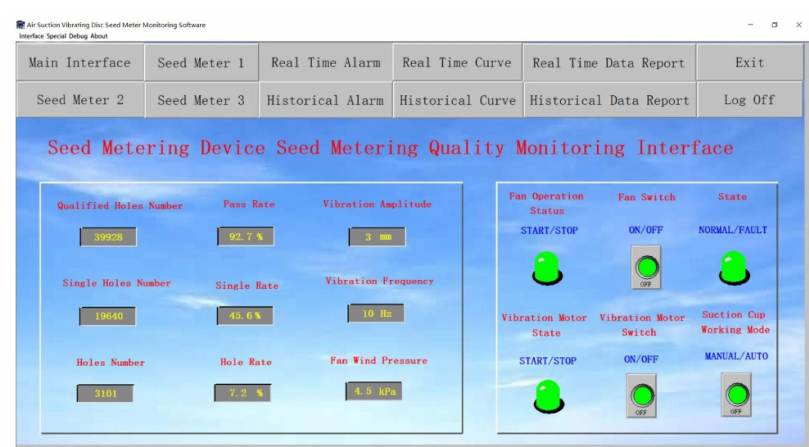
Figure 13. Seed meter running status monitoring interface.